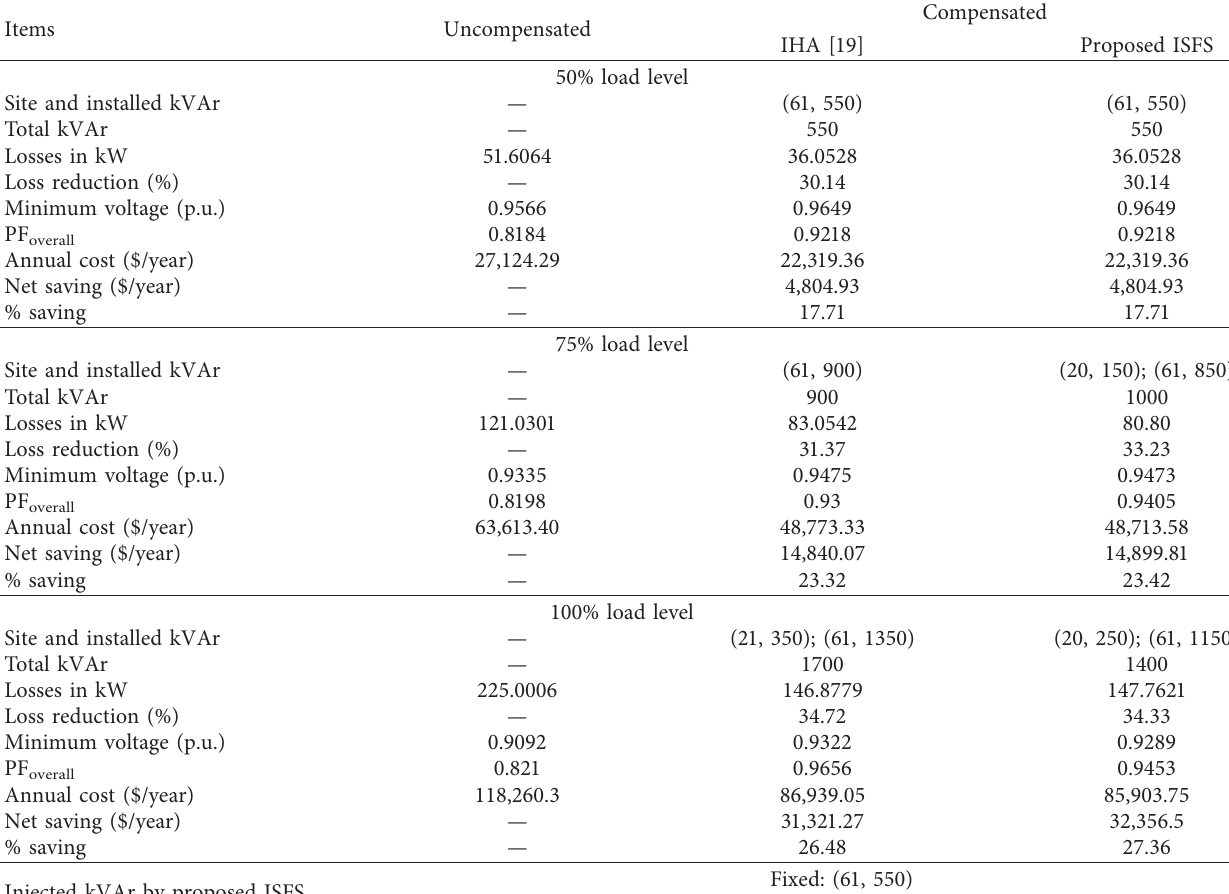
Table 3: Simulation results and comparison for 69-bus network at different loading